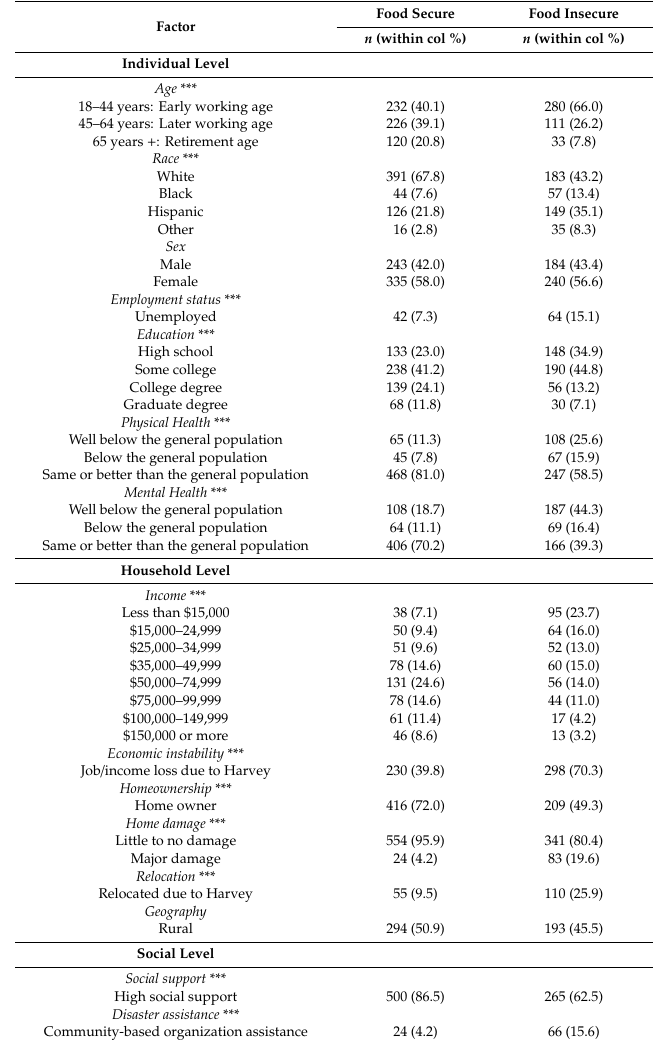
Table 2. Frequency of individual, household, and social factors among the food secure and